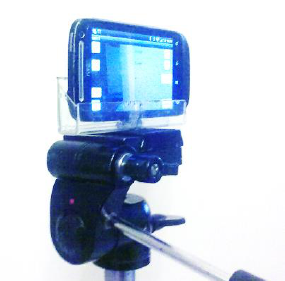
Figure 7. Simple stand use for measurements